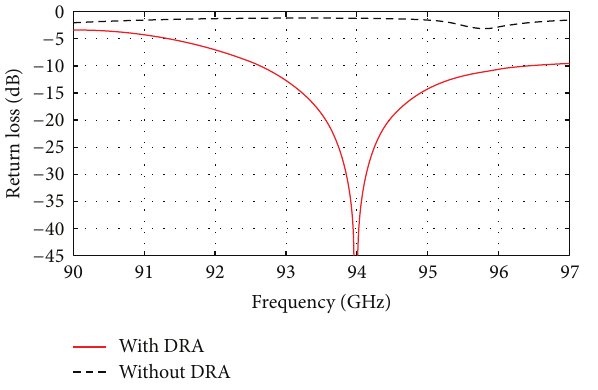
Figure 6: Antenna return loss ( S 11 ), with 𝐿 1 = 14 mm, 𝑊 1 = 10 mm, 𝑊 𝑆 𝐶 𝐶 𝐿 = 2 = 11.68mm, 2 = 5.82 mm, off = 0.06 mm, 𝐿 = 1mm, th 13 𝜇 m, 𝑊 = 0.19 mm, 𝐺 = 20 𝜇 m, 𝐿 𝑠 = 0.75 mm, 𝑊 𝑠 = 0.103 mm, 𝐿 stub = 0.417 mm, 𝐶 off = 0.16mm, and 𝑃 𝑤 = 0.01 mm.